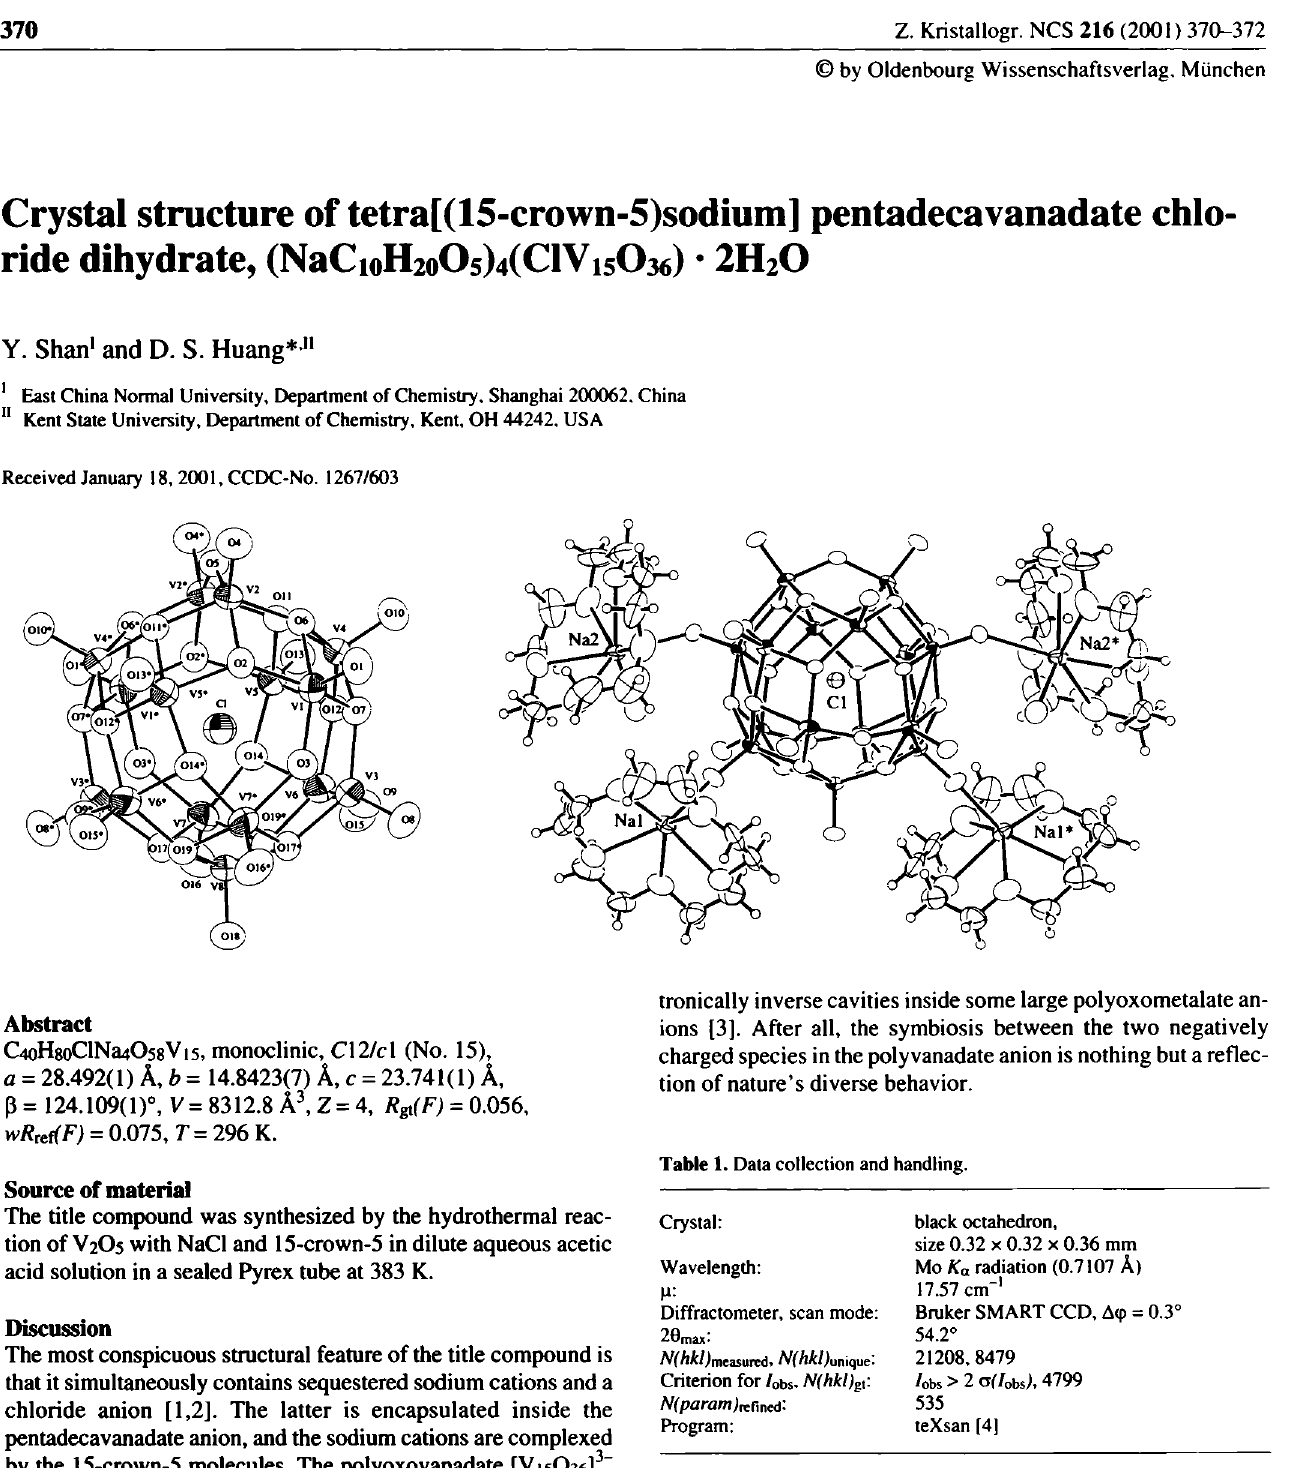
Table 2. Atomic coordinates and displacement parameters (in A 2